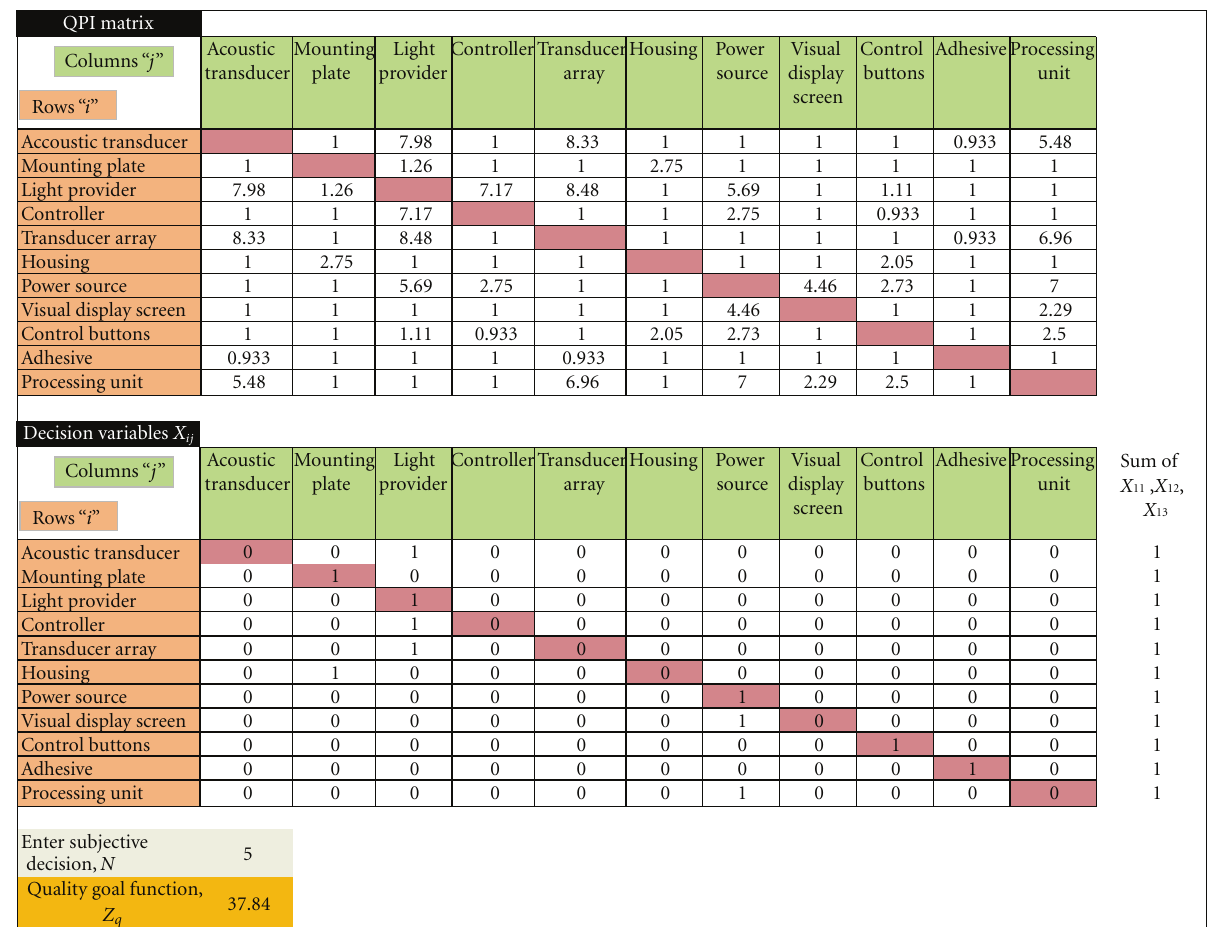
Figure 7: Quality goal function—stakeholder 2 ratings.